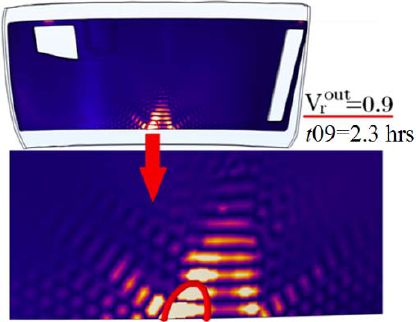
Figure 4. The position of the resin front with the 0.9 filling level just before leaving the outlet at the moment used for the most reliable prediction of the final results of the vacuum infusion process.